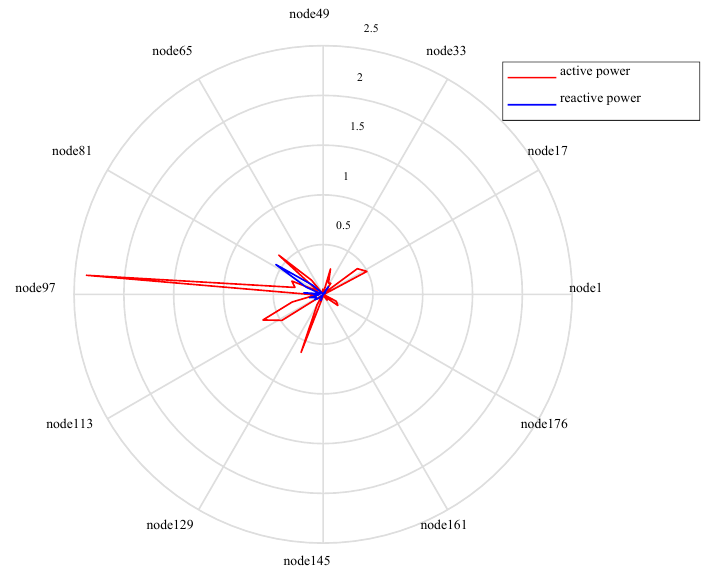
Figure 6. Intermediate power flow power error.